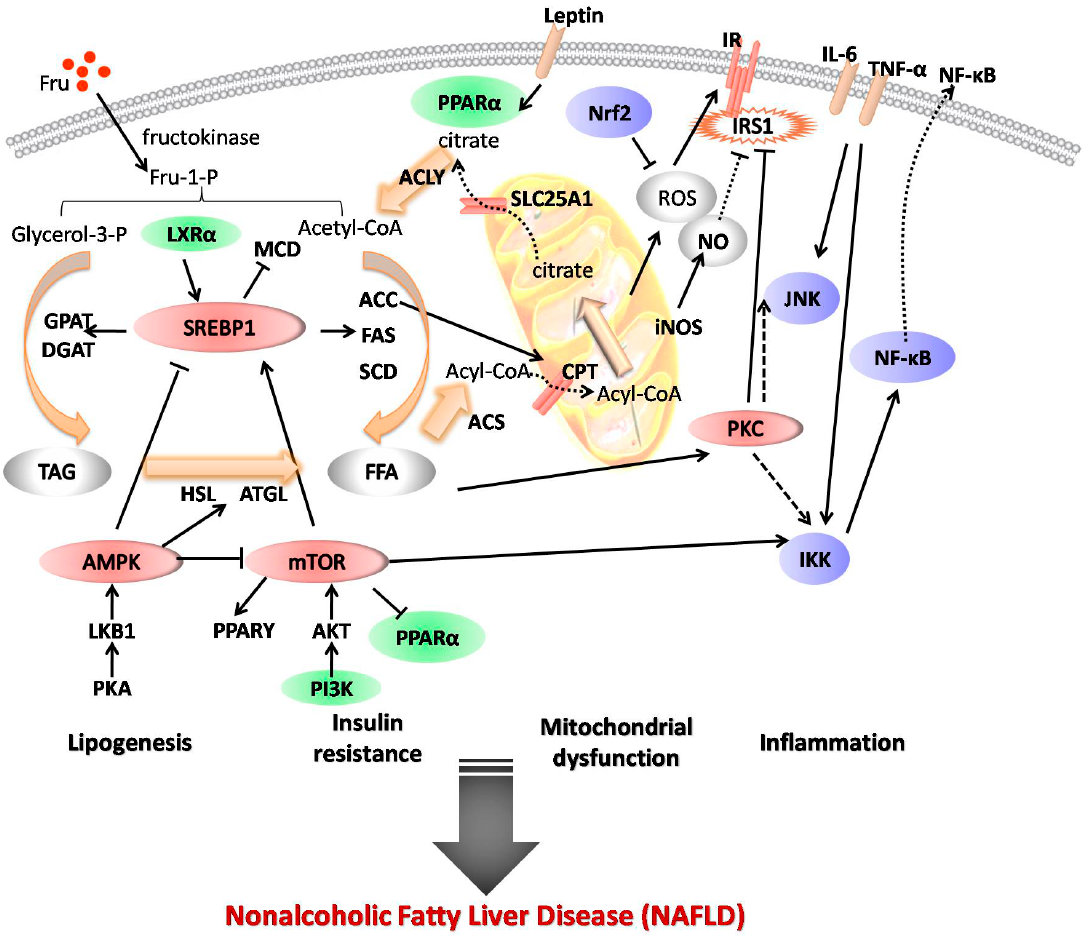
Figure 1. Schematic representation of underlying mechanisms of fructose-induced NAFLD. Fructose may stimulate NAFLD through different pathological processes, including: (1) augmenting lipogenesis through up-regulating liver X receptor (LXR) α and sterol regulatory element binding protein (SREBP)-1c; (2) leading to mitochondrial dysfunction by depressing peroxisome proliferator-activated receptor α (PPAR α ) and nuclear factor-erythroid 2-related factor 2 (Nrf2); (3) stimulating the activation of inflammatory pathways; and (4) causing insulin resistance. ACC: